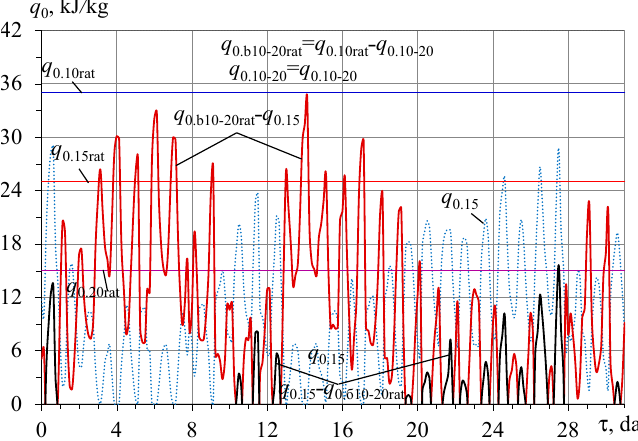
Figure 5. Current values of specific thermal load q 0.15 for cooling ambient air to t a 2 = 15 °C, excesses of available rational design boost cooling capacities q 0.b10-20rat − q 0.15 over required q 0.15 for t a2 = 15 °C, deficit of design boost cooling capacity q 0.15 − q 0.b10-20rat : q 0.10-20 = q 0.10 − q 0.20 , q 0.b10-20rat = q 0.10rat − q 0.10-20 .